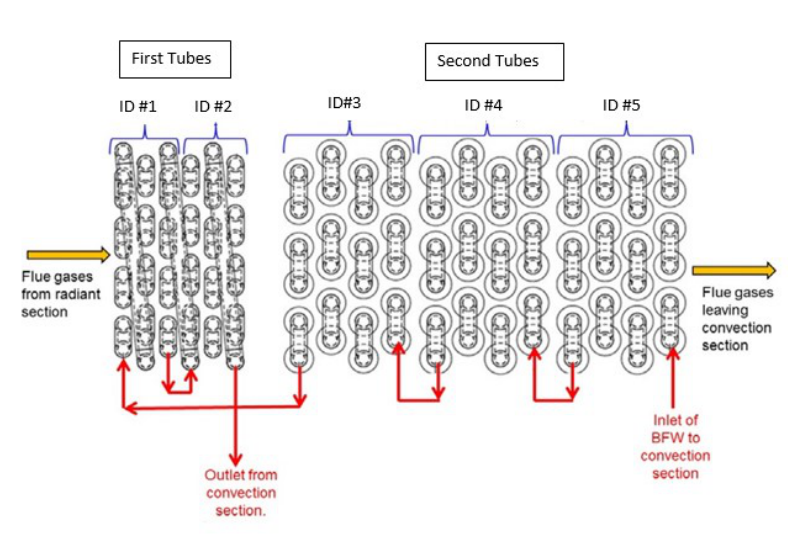
Figure 2. Tubes and flow arrangement in the convection section.